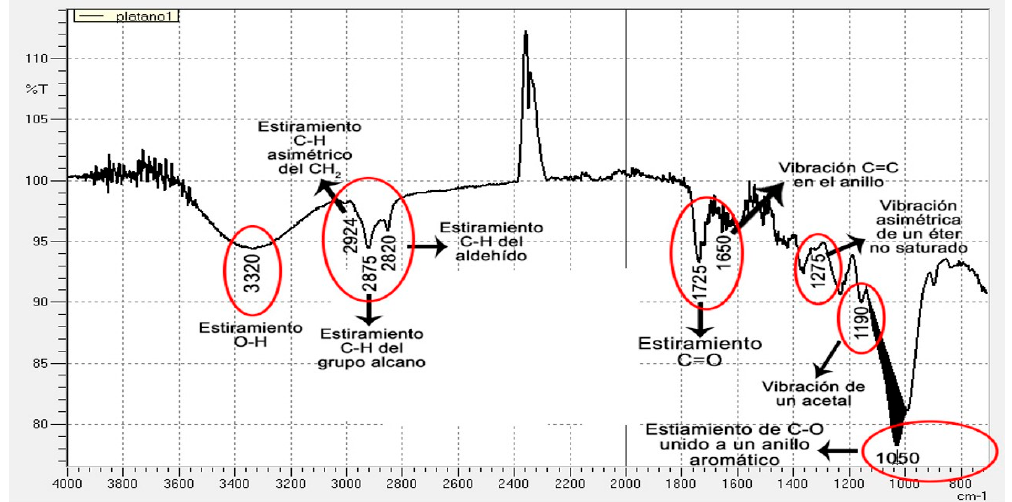
Figure 2. Infrared spectrum of the plantain pseudostem before the application of the bioadsorption process of Cr